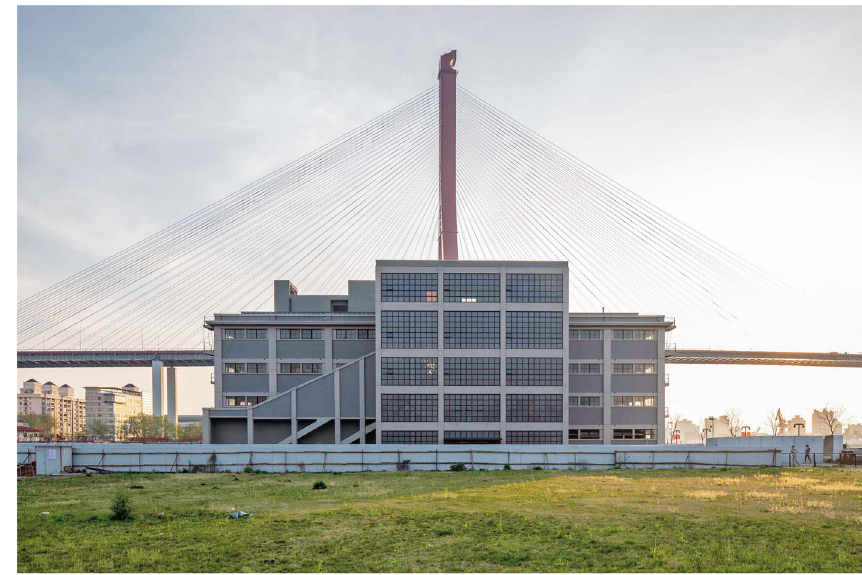
Fig. 19 West Elevation of the west wing after renovation (Source: Fangfang